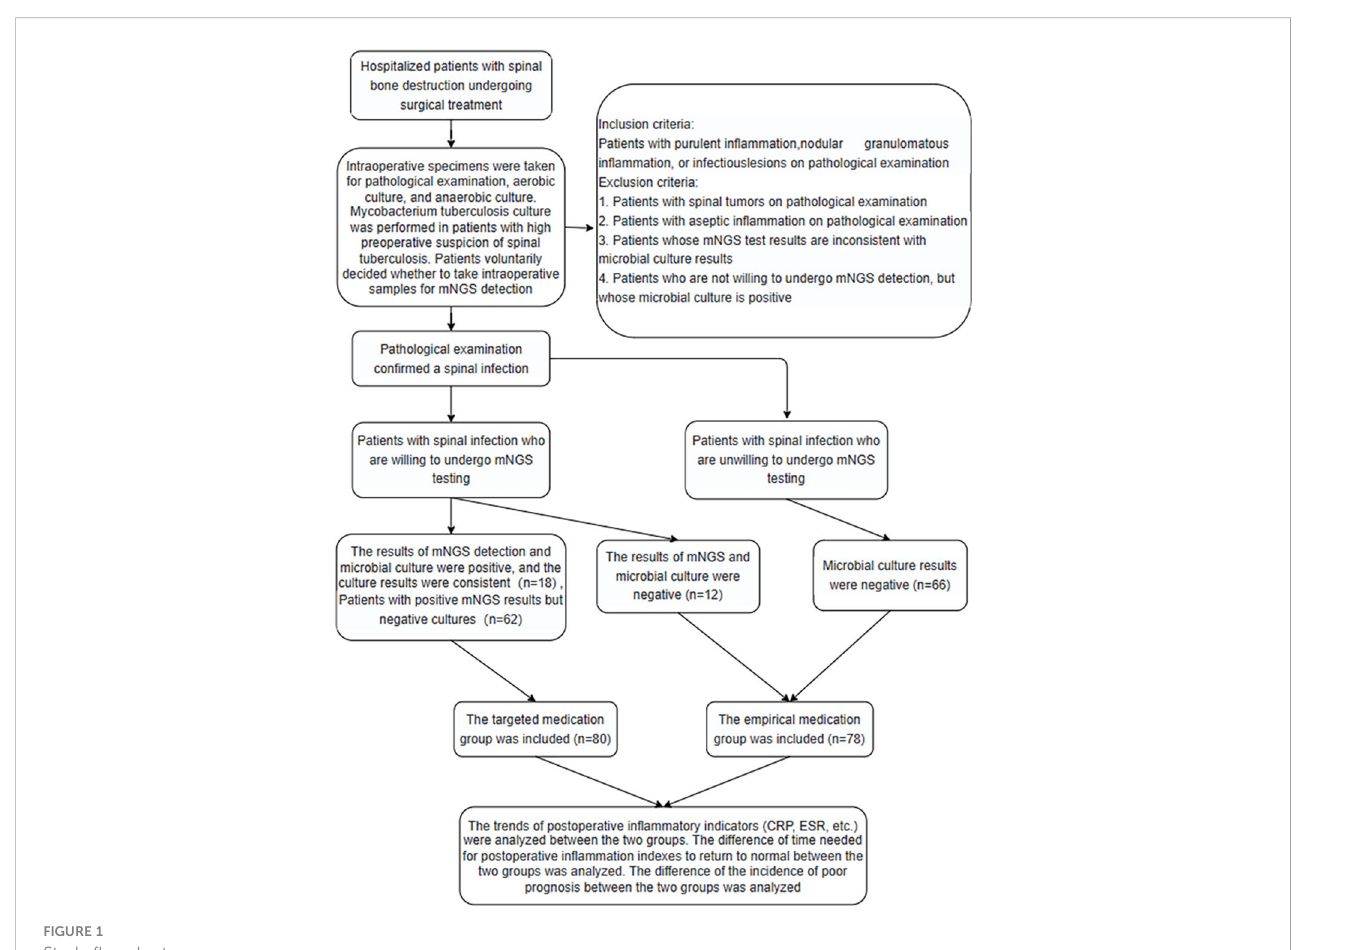
FIGURE 1 Study fl